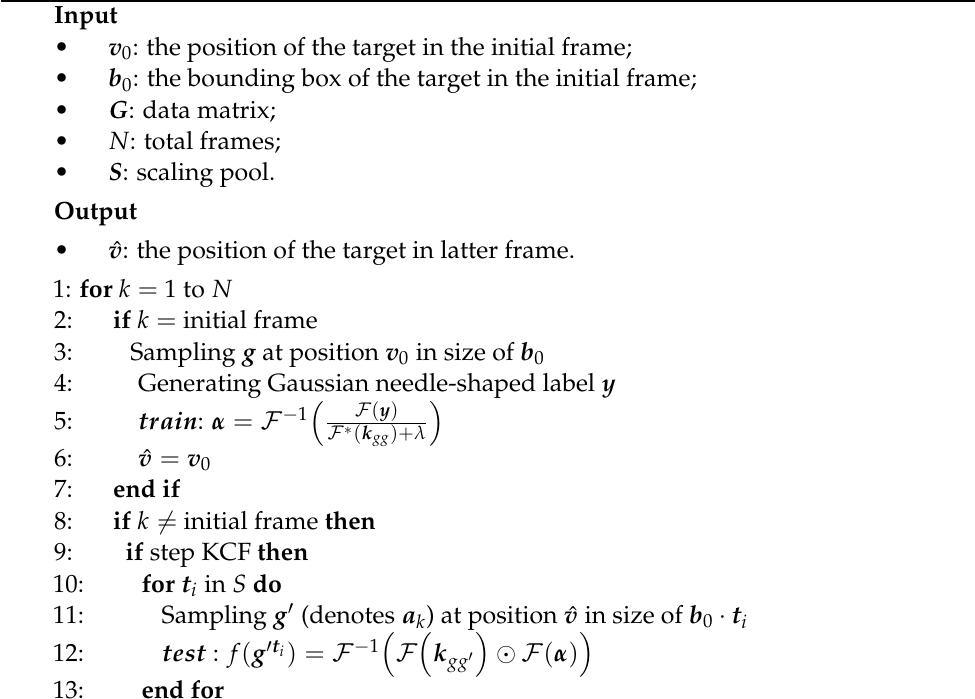
Algorithm 1: Joint correlation filter and Bayes